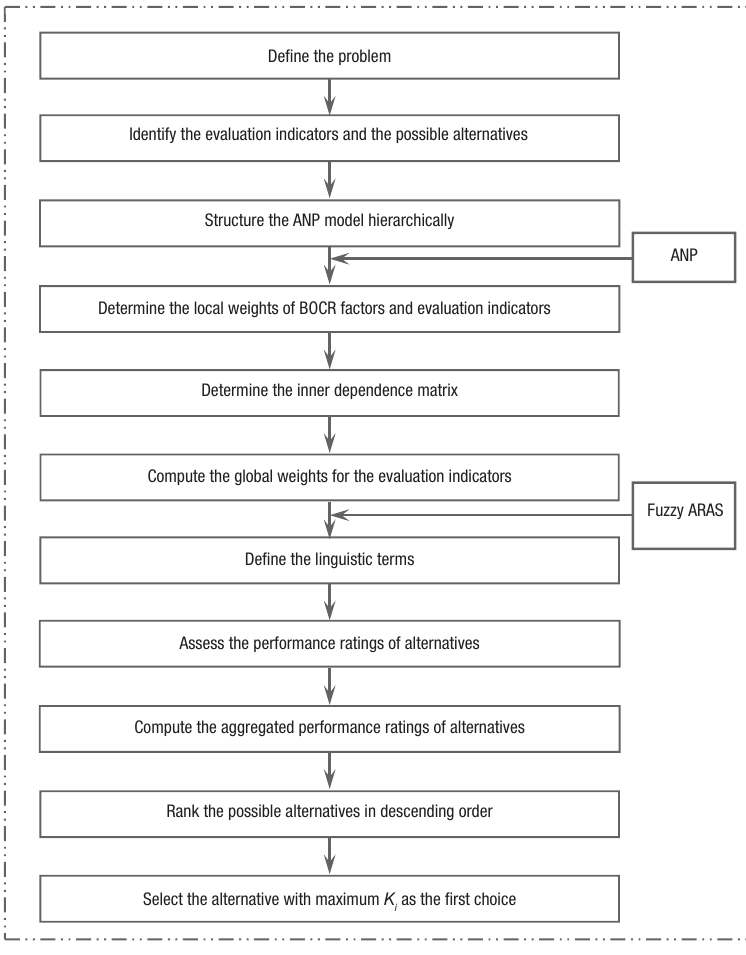
Fig. 3. The outline of the proposed